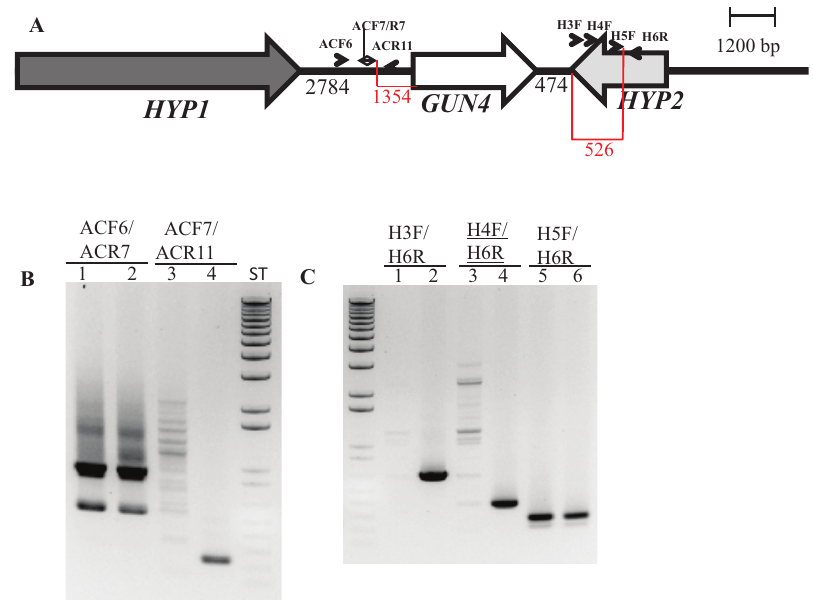
Figure S5. PCR using primers specific to the upstream region of GUN4 and the 3 ′ UTR of the HYP2 gene. ( A ) A schematic diagram showing GUN4 (white arrow) and its two neighboring genes HYP1 (black arrow) and HYP2 (grey arrow). Black numbers at the bottom denote distances between respective genes. The two red highlighted regions and corresponding numbers show the distance between primer ACF7 and the start of the GUN4 gene and the distance between the primer H5F and the end of the HYP2 gene, respectively. Primers used for PCR are labeled. ( B ) A DNA gel showing the genomic DNA amplified using GUN4 upstream region specific primers. Lanes 1, 3 and 5: 6F14 ; Lanes 2, 4 and 6: 4A+. ( C ) A DNA gel showing the genomic DNA amplified using primers spanning the 3 ′ UTR region of HYP2 gene. Lanes 1, 3 and 5: 6F14 ; Lanes 2, 4 and 6: 4A+. Product size of ACF6/ACR7: 937 bp (this primer set also produces a nonspecific 550 bp product); product size of ACF7/ACR11: 244 bp; product size of H3F/H6R: 667 bp; product size of H4F/H6R: 391 bp; product size of H5F/H6R: 278 bp. F and R stand for forward and reverse primers, respectively. Primer sequences are shown in Table